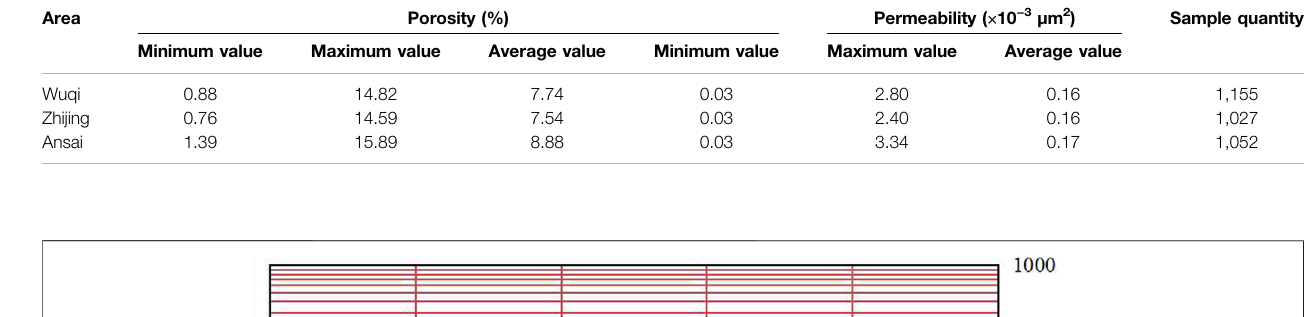
FIGURE 5 | Capillary pressure curve of Chang 8 in study area.